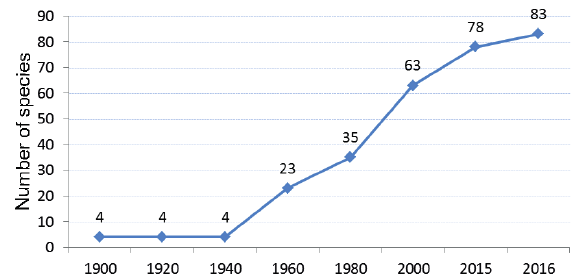
Figure 1. Cumulative number of known species of the genus Aegla Leach, 1820, since